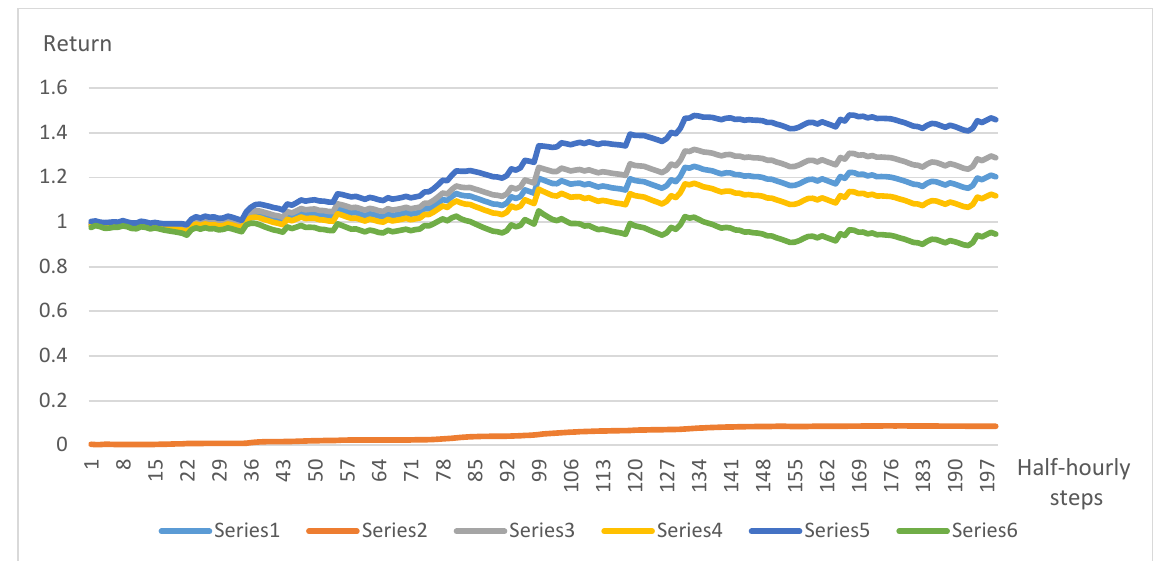
Figure 14. Confidence intervals of return on 3 stocks’ portfolio (UK market, half-hourly data) (source: compiled by the authors based on Yahoo Finance data and own calculations).